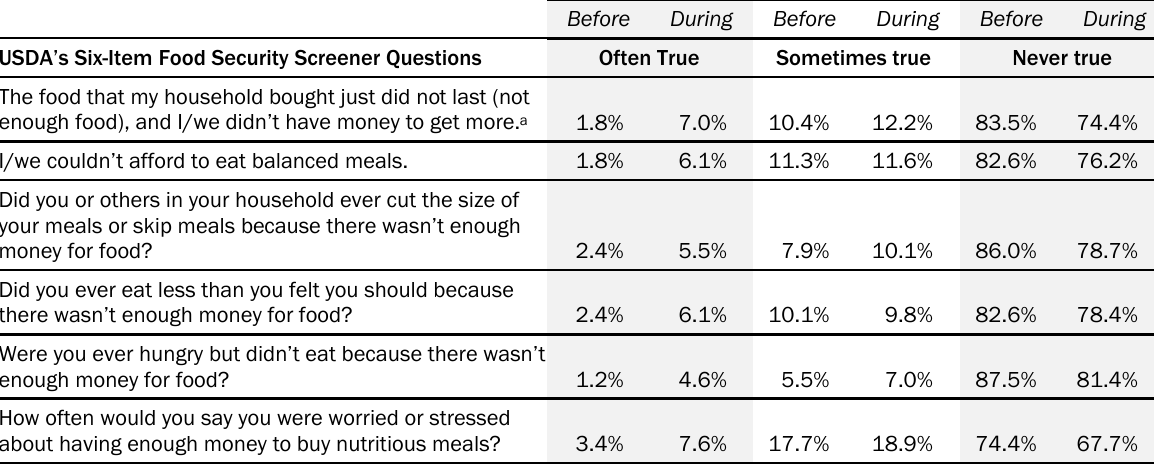
Table 1. North Carolina Participant Responses to Food Security Status Before and During COVID-19 ( N =383)